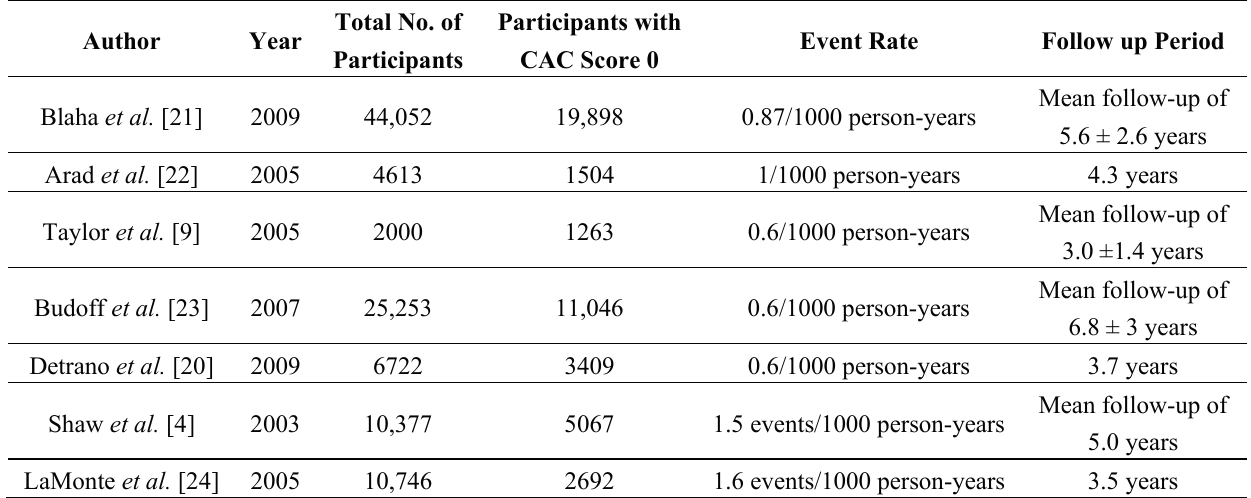
Table 1. Predictive value of zero coronary artery calcium